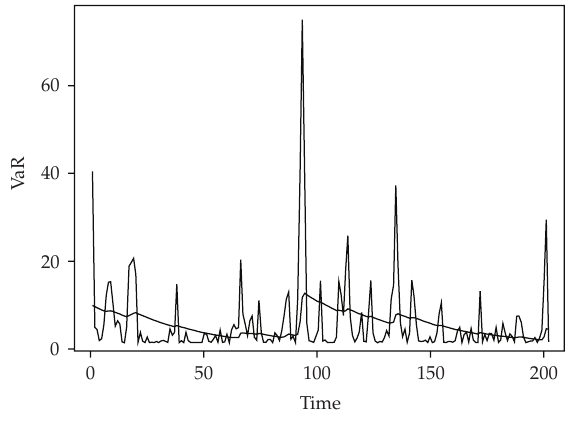
Figure 4: True and IGARCH-Based